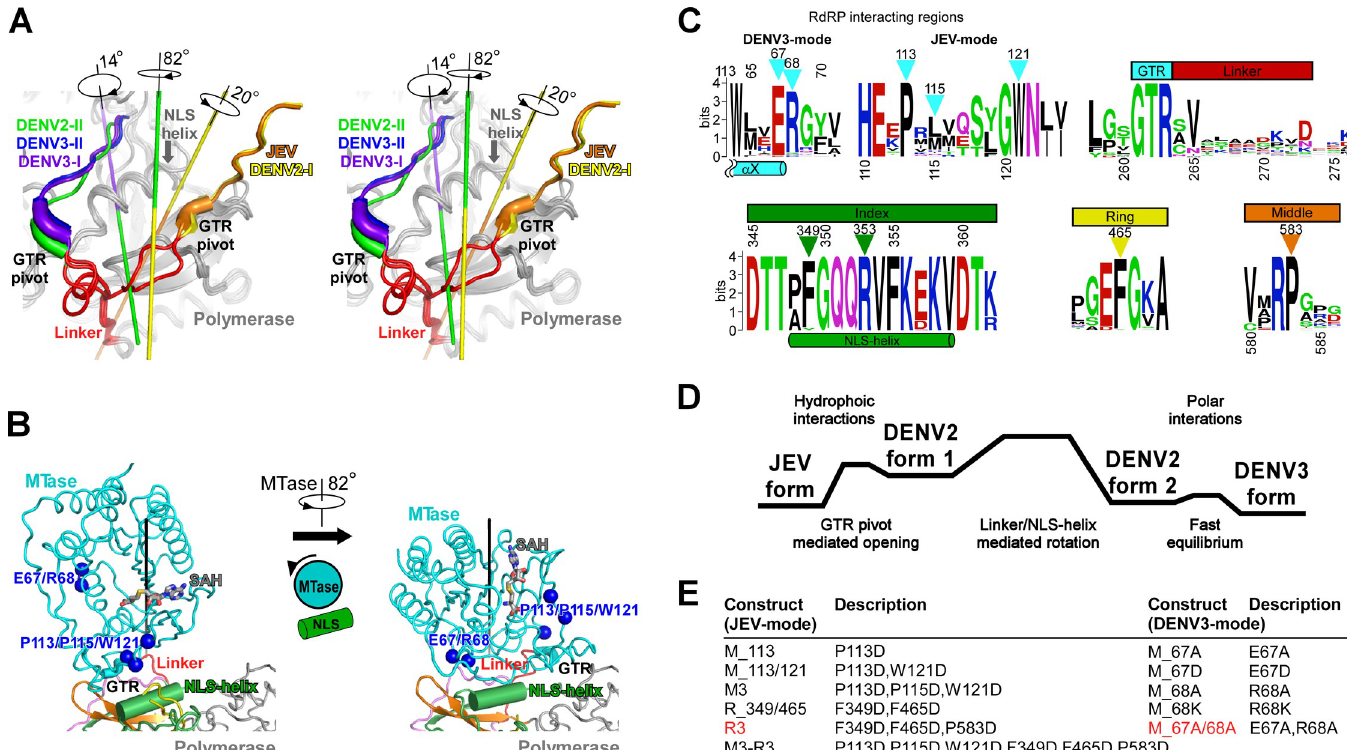
Fig 3. Key elements that may mediate the conformational switches of the flavivirus NS5. A) Stereo-pair images (wall-eyed) shown in a view looking at the MTase- RdRP linker region. For clarity, the entire RdRP region is shown in grey, linker is in red, and only the C-terminal ten residues including the very C-terminal GTR sequence of the MTase are shown. B) A comparison between the two DENV2 conformational states highlights a likely role of the highly conserved index finger NLS-helix. Left: JEV- mode; right: DENV3-mode. The coloring scheme is the same as in Fig 1. The α -carbon atoms of two important patches of residues are shown as blue spheres. C) The sequence logo plot showing the conservation of the two RdRP interacting regions, the GTR-linker region (top panel), and the NLS-helix that is important for both JEV- and DENV3-mode conformational states, the middle and ring finger regions only critical in JEV-mode states (bottom panel). The triangles indicated key residues involved in the intra-molecular interactions. D) A schematic free energy diagram for all four conformational states of flavivirus NS5. The relative free energy was crudely estimated by the solvent accessible surface area occluded by the NS5 intra-molecular interface interactions. E) A list of DENV2 NS5 mutants that were designed based on both the JEV- and DENV3-mode conformations, with abbreviations and full descriptions, including mutation site and mutation type.